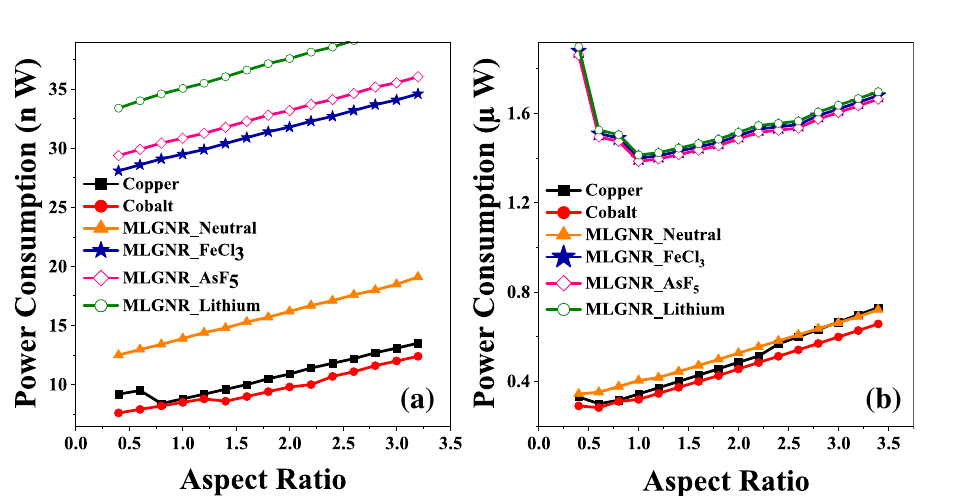
Figure 6. Comparison of power consumption in interconnects at ( a ) intermediate level (L = 10 µ m) and ( b ) global level (L = 1 mm)